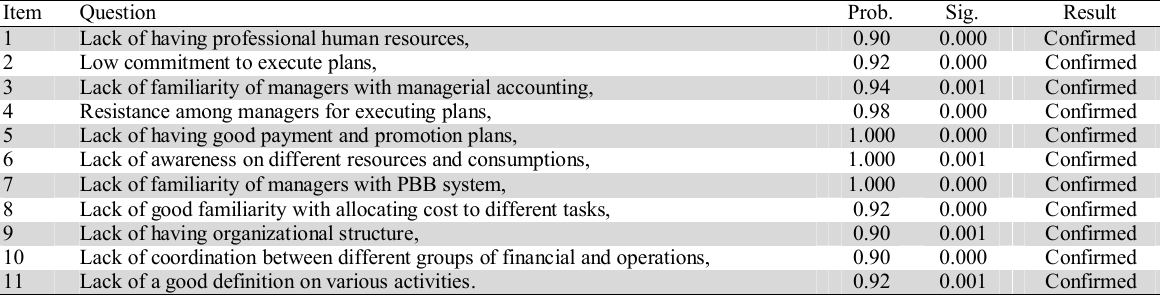
The summary of the responses associated with the second